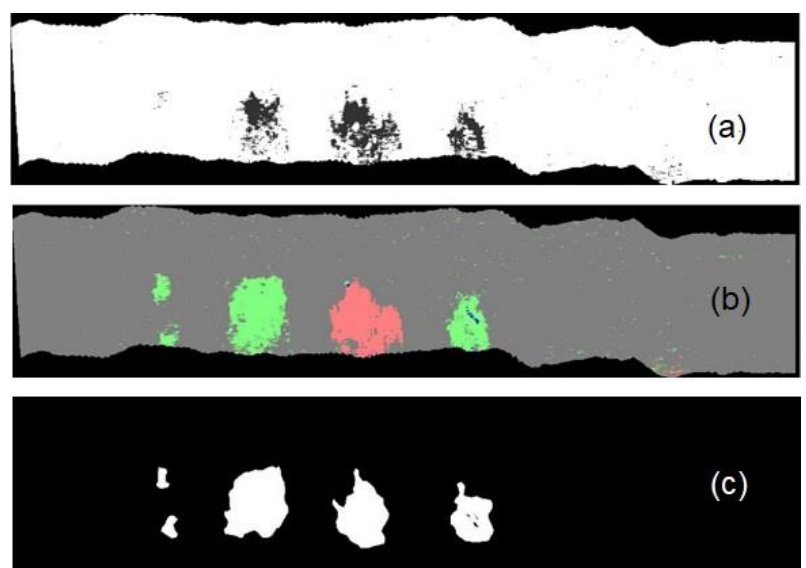
Figure 10. ( a ) Result of classification for the classifier trained on Set 1 (all plastics together); ( b ) combined classifier (Set 4 OR Set 5): Green denotes detected PE, pink denotes PET, and blue points where both classifiers respond positively; ( c ) manually drawn materials identification mask for all plastics.